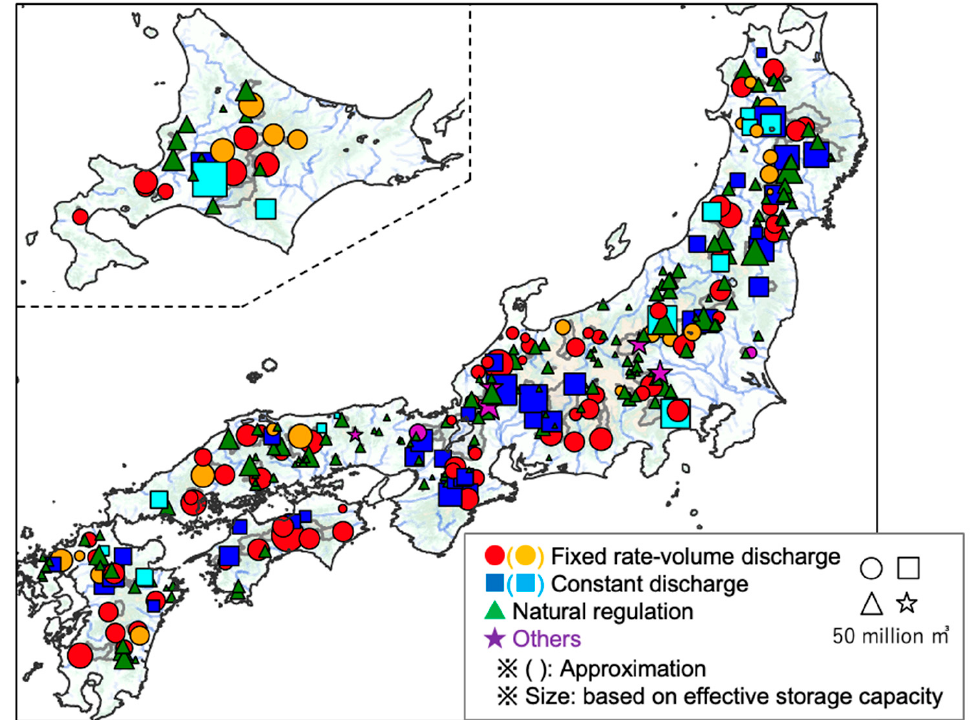
Figure 2. Distribution and regular rules of all multi-purpose reservoirs from class A rivers in Japan.